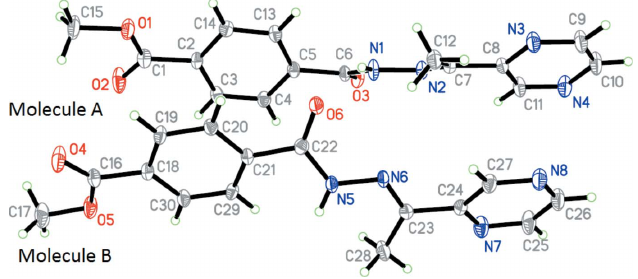
Figure 1 The molecular structure of the title compound showing the atom numbering and displacement ellipsoids drawn at the 50% probability